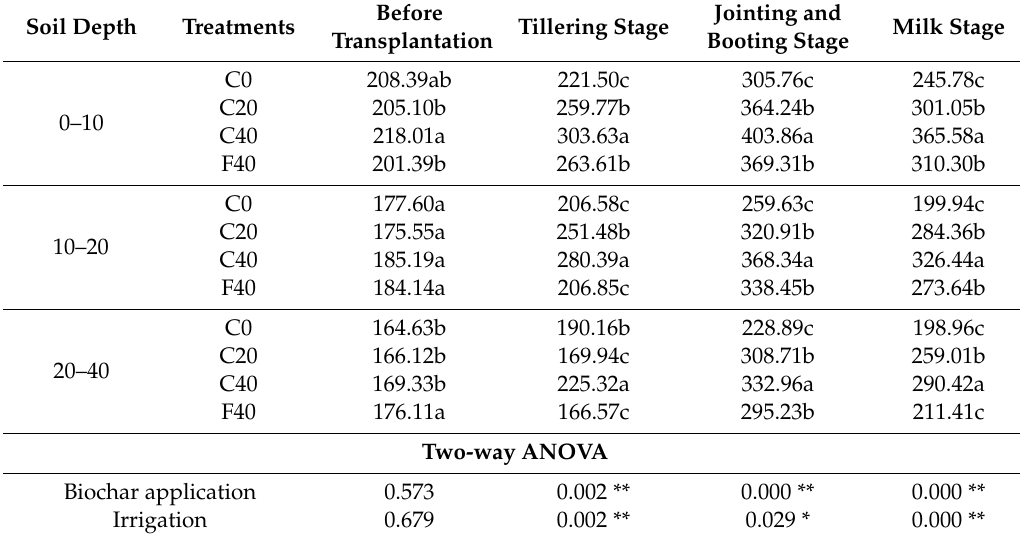
Table 2. Characteristics of soil water-soluble organic carbon (WSOC) under di ff erent water-carbon regulation scenarios in paddy fields (mg / kg).